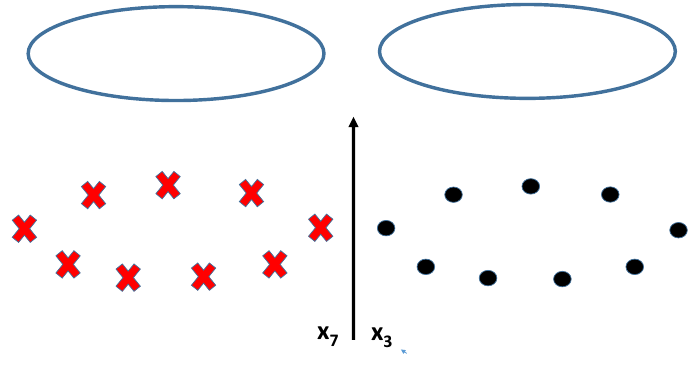
Figure 4: Higgs branch deformation of the quiver gauge theory and the dual Coulomb branch deformation of its